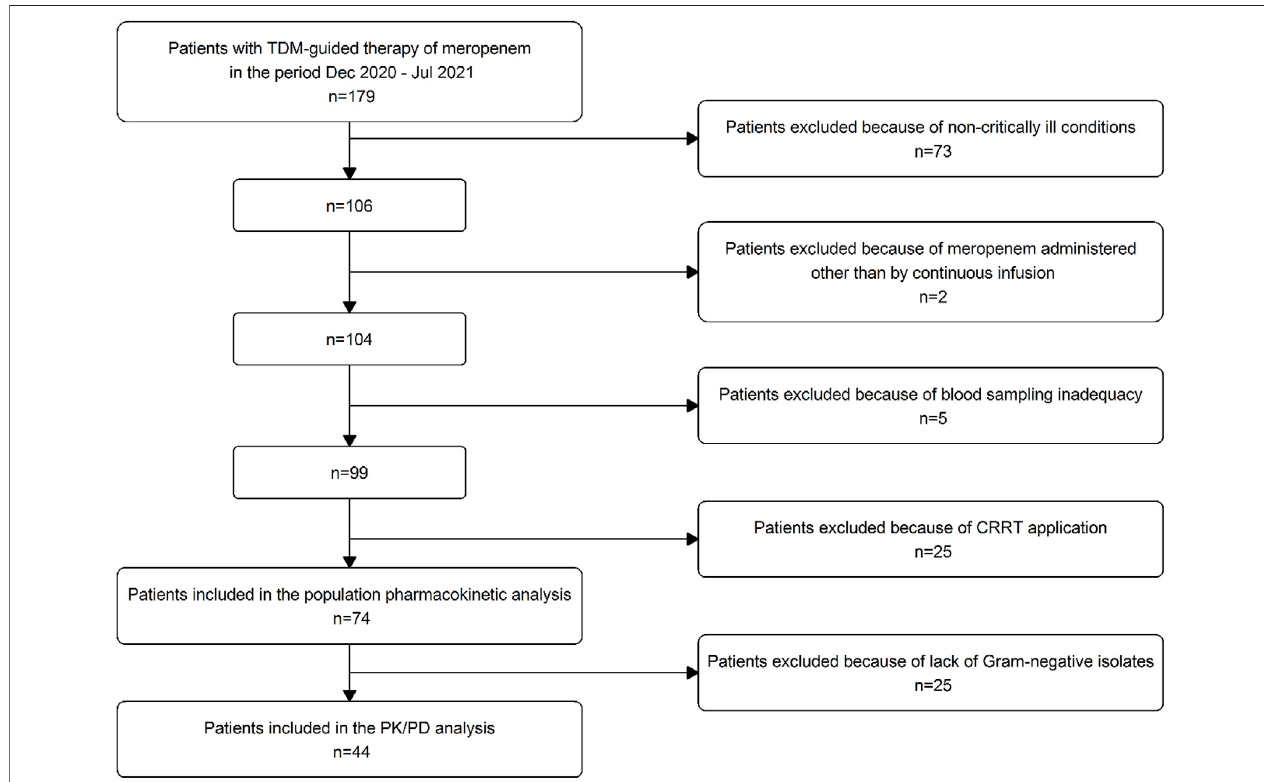
FIGURE 1 | Flow chart of patient inclusion and exclusion